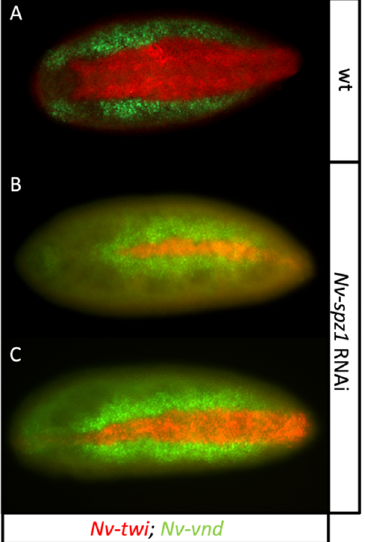
Figure 11. RNAi knockdown of Nv-spz1. ( A ) Ventral view of Nv-twi and Nv-vnd (red and green, respectively) in a wildtype embryo in late blastoderm stage. ( B , C ) A strong ( B ) and a weaker ( C ) Nv-spz1 dorsalizing phenotype in late blastoderm embryos. Table 1. Summary of Toll Pathway component expression in the fly and wasp. Tissue-based expression domains in both the fly and wasp are provided for each pathway component based on previous [88–90] and current studies (color has been added to emphasize similarities/differences). RNAi phenotypes observed in the wasp include: X = no phenotype, D = dorsalized, I = immune/sick wasps, F = flaccid/fragile eggs, N/A = not tested. YES